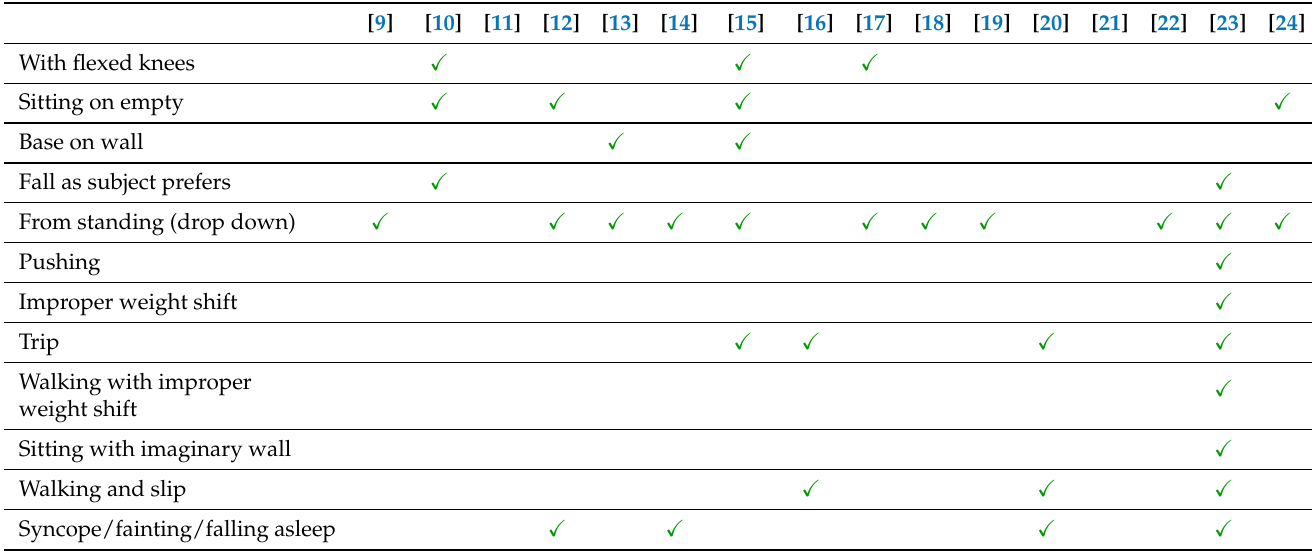
Table 2. Fall types considered in previous datasets. Reference [11] is empty as it does not consider any fall